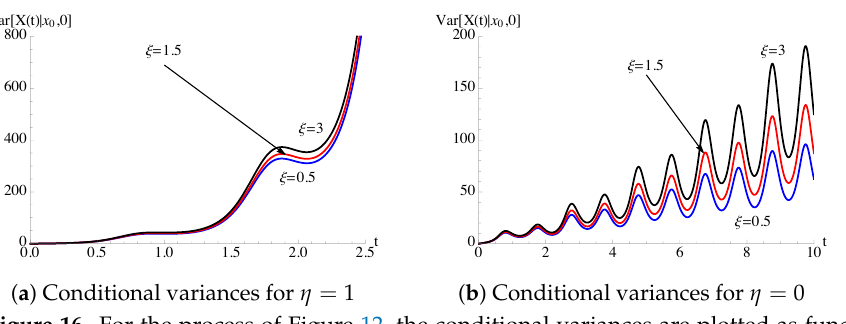
Figure 16. For the process of Figure 12, the conditional variances are plotted as function of t for various choices of ξ